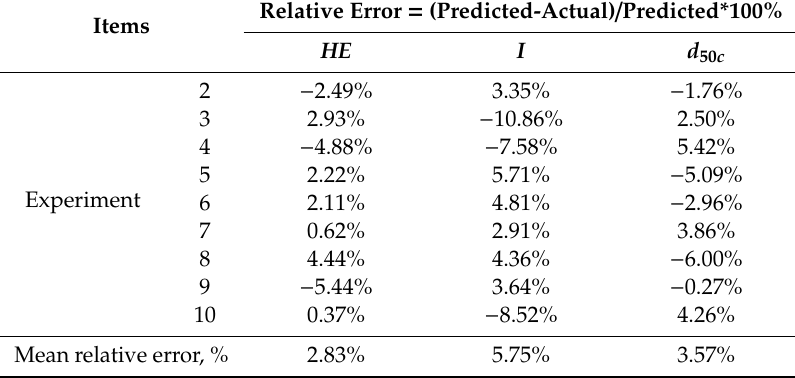
Figure 6. Comparison of the actual and predicted performance evaluation ( a ) Hancock classification Table 6. Error